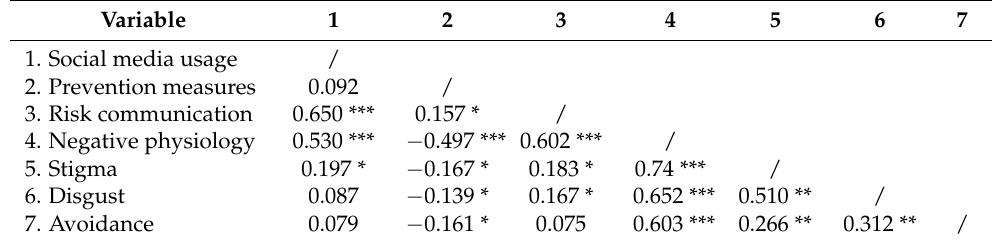
Table 3. Bivariate Correlations Estimates.